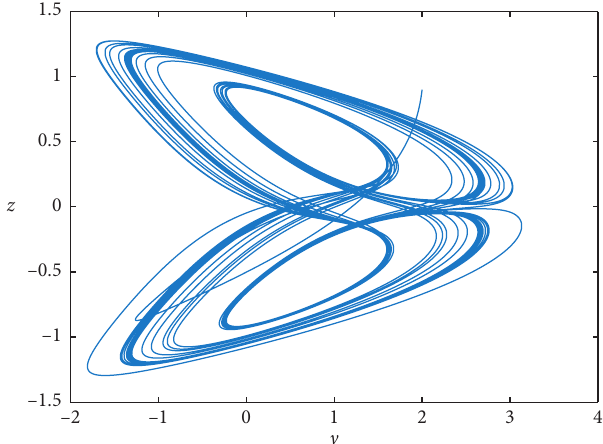
Figure 2: Dynamic behavior of fractional financial chaotic model with α � 0 . 95.